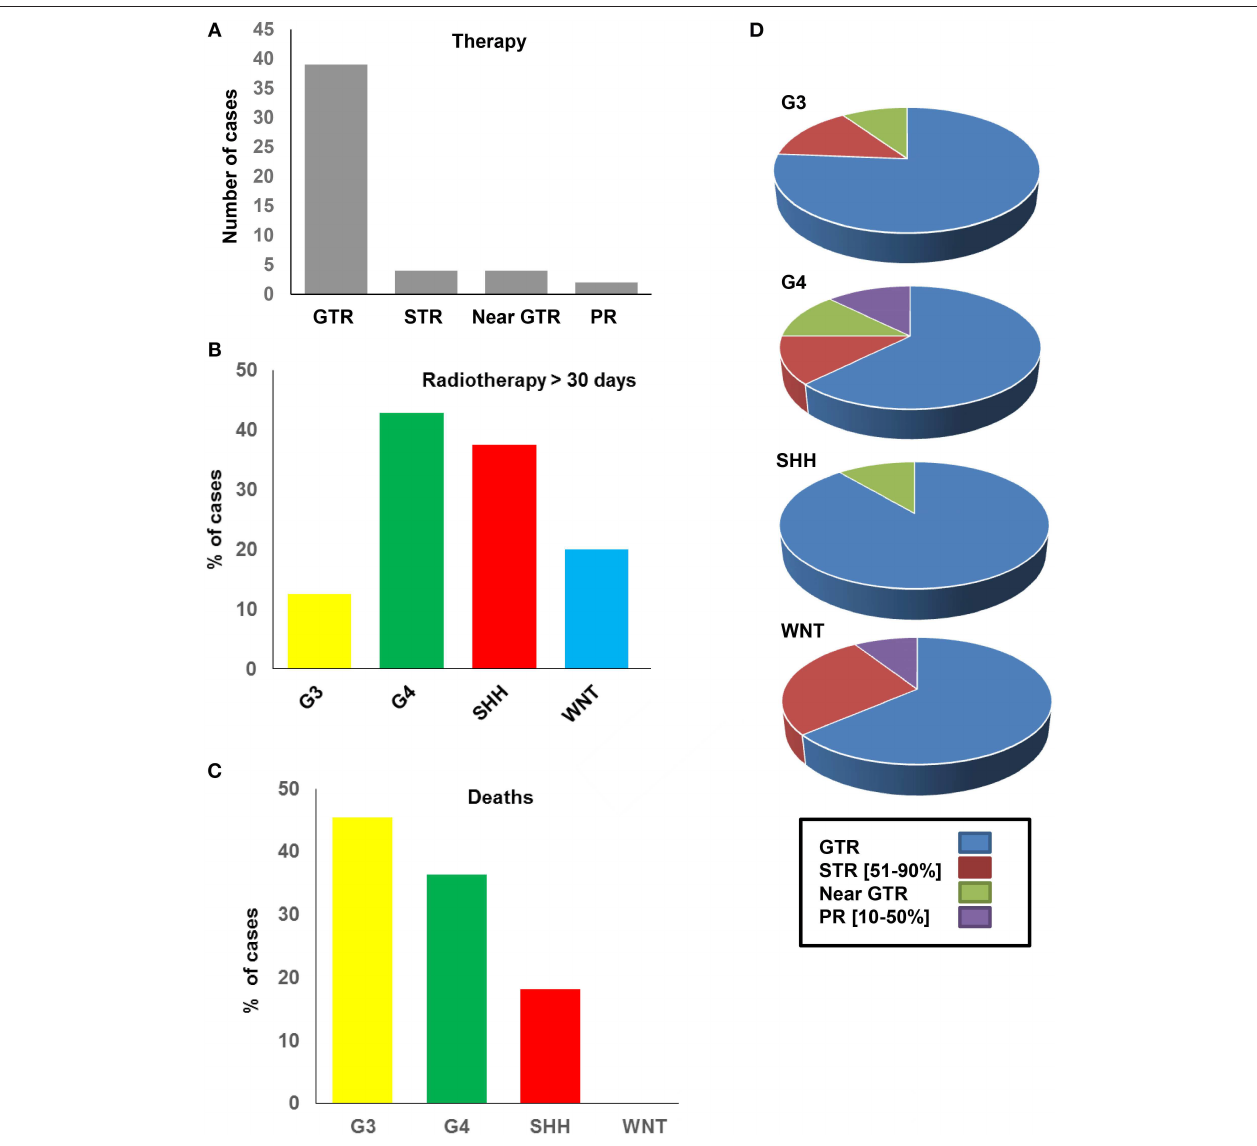
FIGURE 4 | Therapeutic strategy and outcomes of the SA medulloblastoma methylation subgroups. (A) Number of cases received GTR, STR, near GTR, and PR surgical resection. (B) Percentage of cases in each subtypes which received radiotherapy. (C) Percentage of deaths in each subtype. (D) Percentage of GTR, STR, near GTR, PR in each molecular